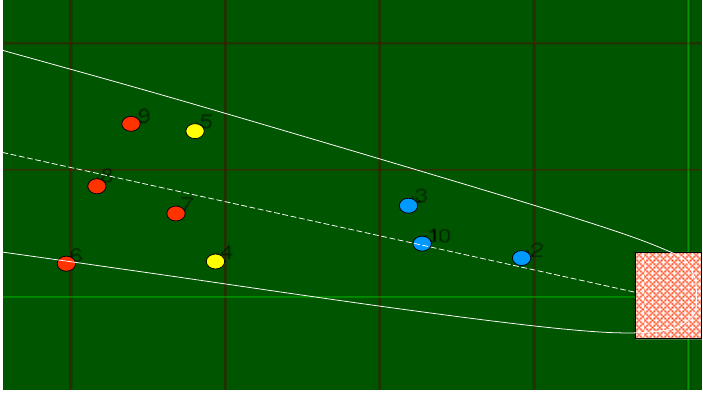
Figure 7. Positions of three trucks: Truck 1 (blue), Truck 2 (yellow), and Truck 3 (red) during the 9 April 2008 prescribed burn at Fort Benning. Grid outlines one mile